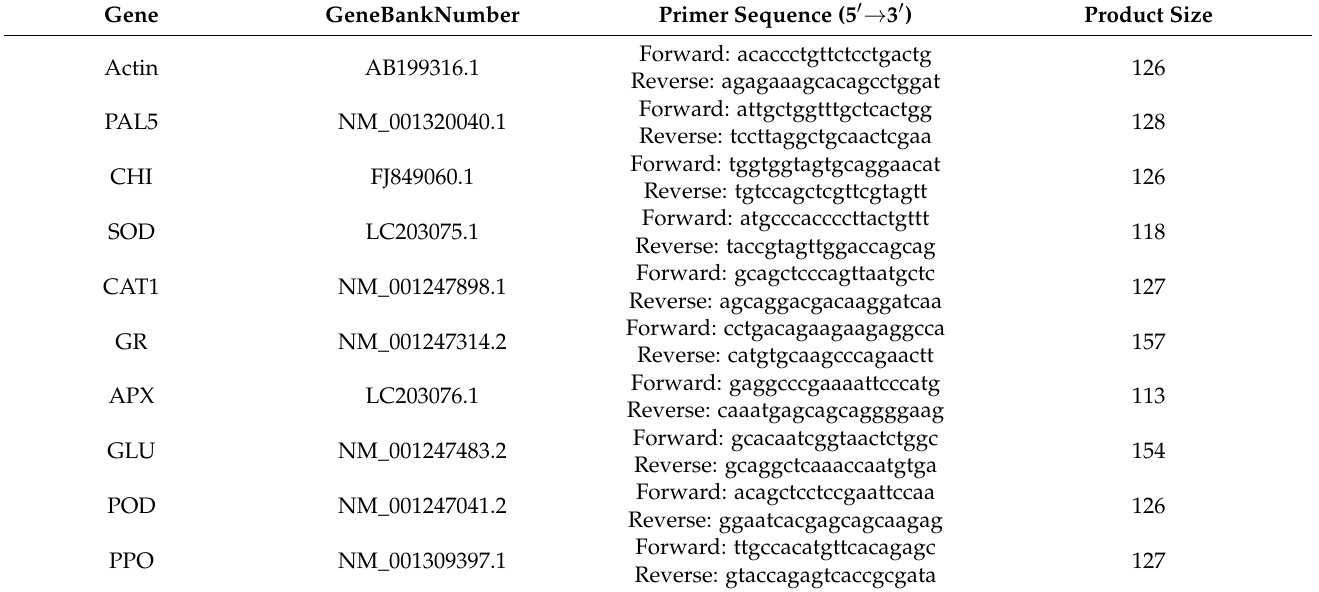
Table 2. Sequences of